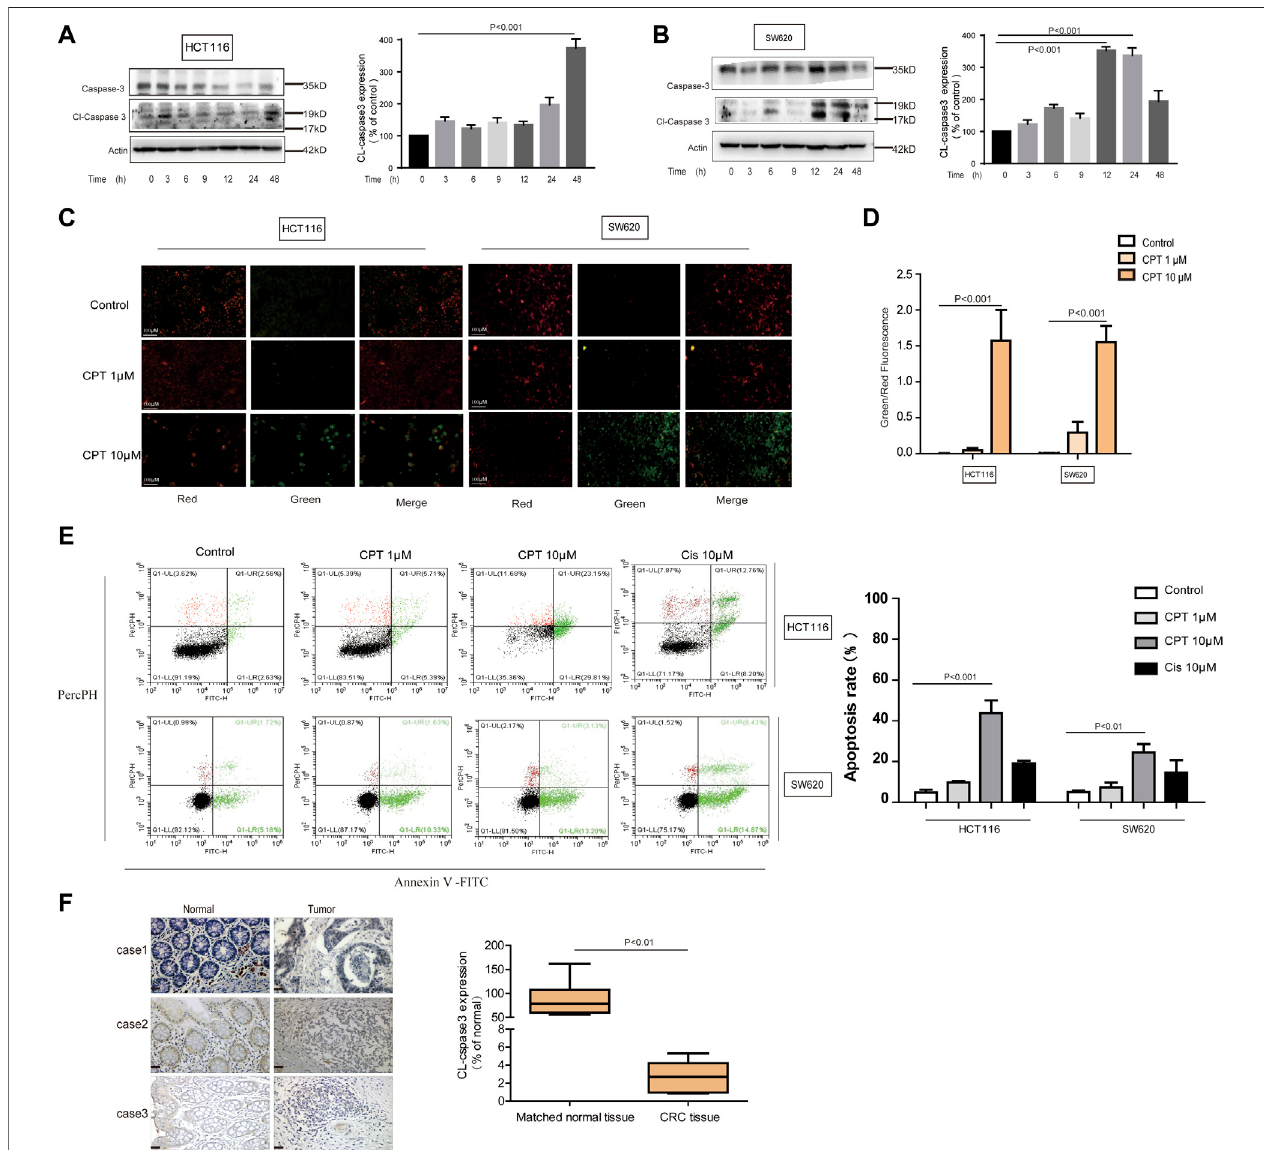
FIGURE3| CPTcaninduceapoptosisofCRCcells.Caspase3andcleavedcaspase3inthelysatesofHCT116andSW620cellstreatedwithCPT(10 μ M)fordifferenttime weredetectedbywesternblotassayandquanti fi edbyImageJ (A,B) .TheJC-1assaywasusedtodetectHCT116cellsandSW620cellstreatedwithdifferentconcentrationsof CPTfor48 h.Thechangeofredorgreencolorwasobservedunder fl uorescencemicroscope(200 × ) (C) andgreen/redwascalculated (D) ( n (cid:2) 3).ApoptosisofHCT116cellsand SW620 cells treated as in (C) was determined by Annexin Ⅴ -FITC/PI staining (E) . The immunohistochemical analysis of the clinical samples were performed, and the expressionofcleavedcaspase3wasdetectedinthetumortissueandthecorrespondingpara-cancertissue,andthequanti fi cationanalysiswasperformedwithImageJ (F) .CPT, cryptotanshinone; CRC, colorectal